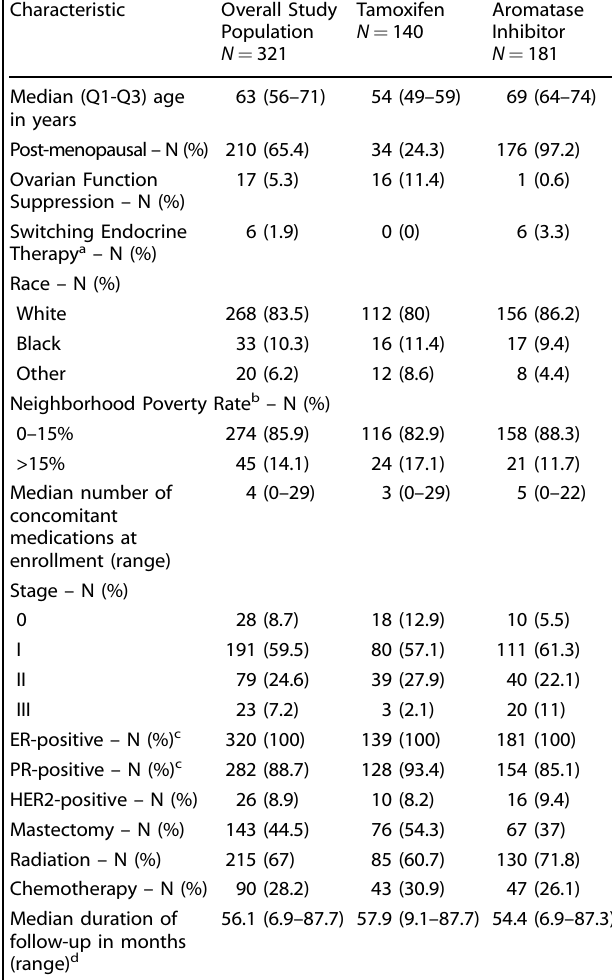
Table 1. Characteristics of study population according to type of endocrine therapy initiated at study